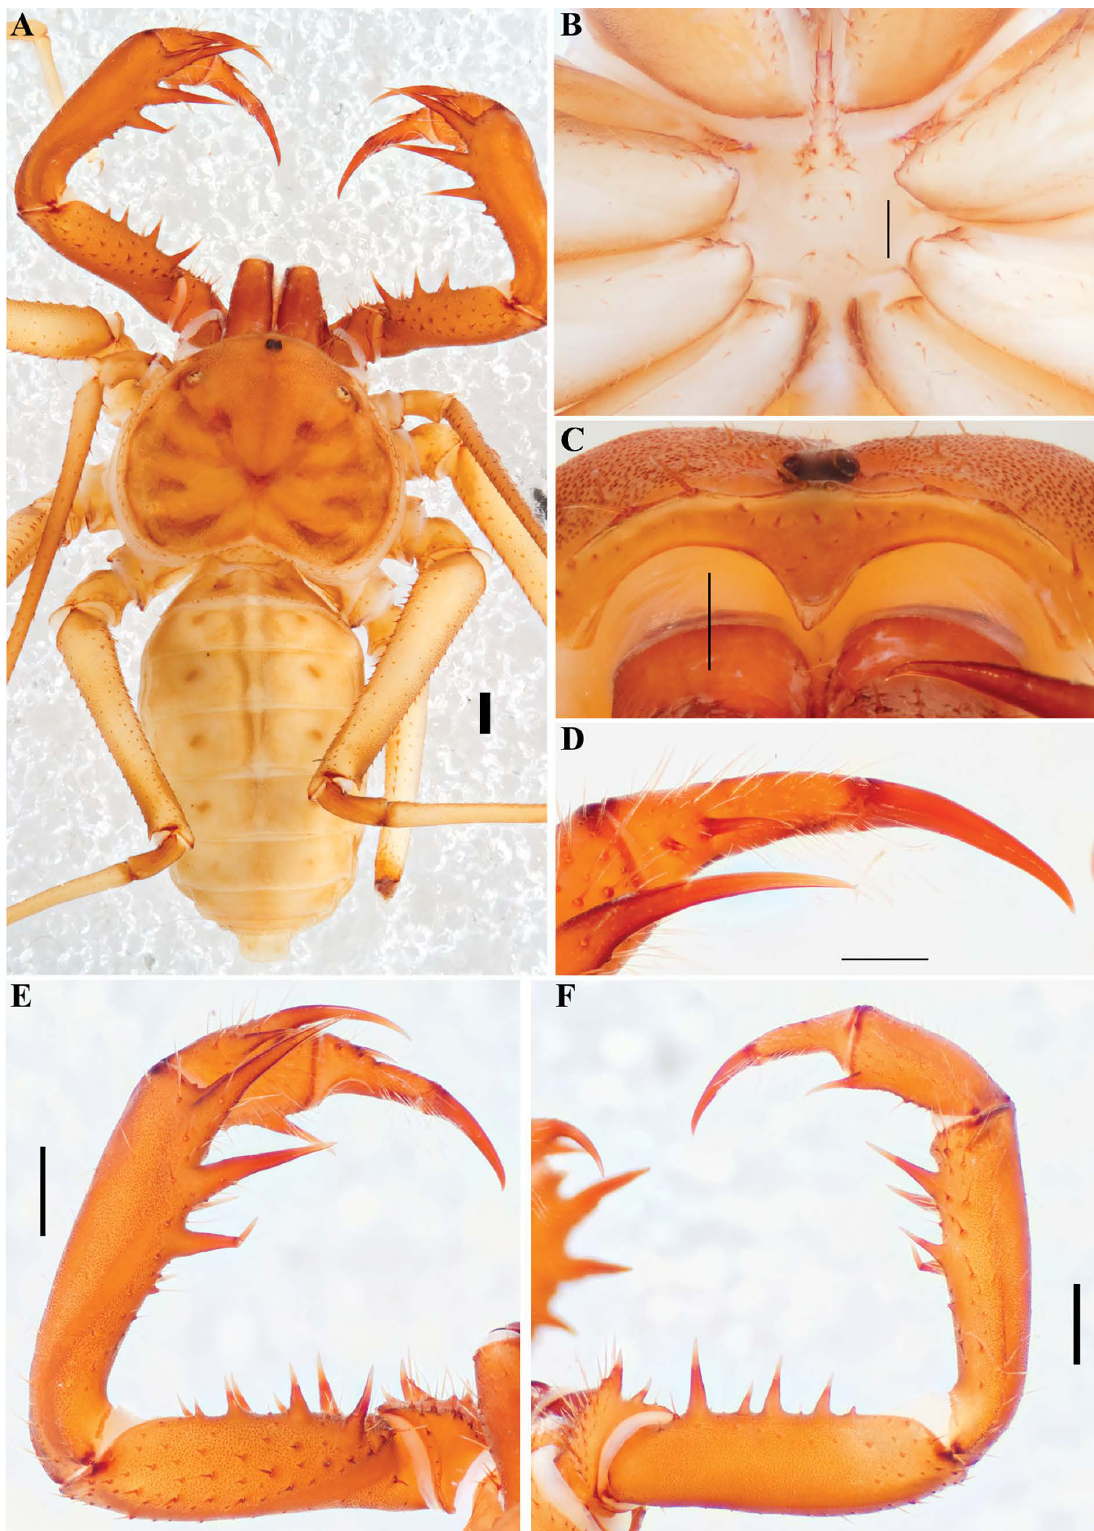
Fig. 96. Charinus elegans Weygoldt, 2006 (MNHN), general morphology, ♀. A . Habitus, dorsal view. B . Sternum, ventral view. C . Frontal process. D . Pedipalp tarsus, frontal view. E . Pedipalp, dorsal view. F . Pedipalp, ventral view. Scale bars: A, E–F = 1 mm; B–D = 0.5 mm.